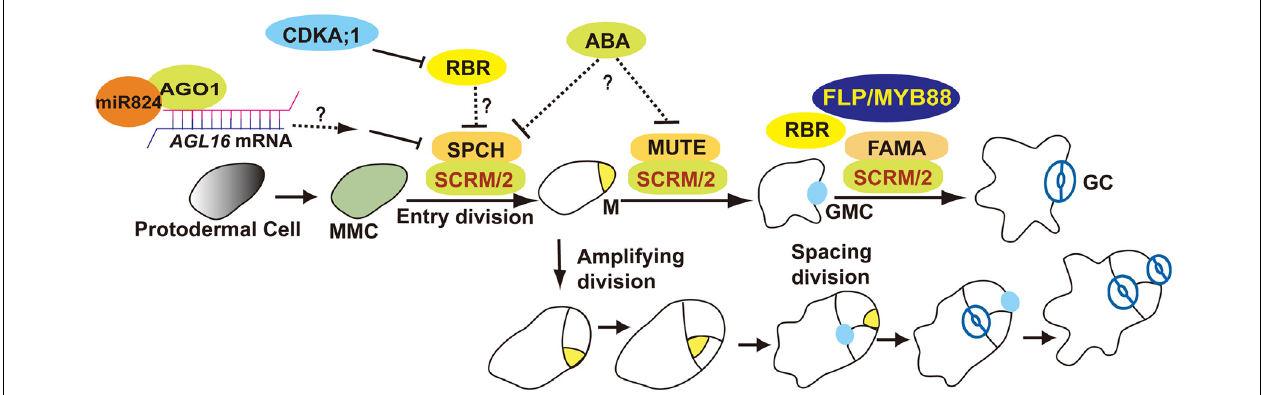
GMC. SPCH, MUTE, FAMA, and FLP/MYB88 are transcription factors that regulate key fate transitions during stomatal development. SCRM and SCRM2 heterodimerize with SPCH, MUTE, and FAMA to promote stomatal–lineage transitions. AGO1 is involved in an AGL16-mediated microRNA post-transcriptional regulatory pathway that blocks asymmetric spacing divisions in SLGCs. ABA might be involved in stomatal initiation and differentiation by repressing SPCH and MUTE. RBR activity is predominantly regulated by CDKA;1. RBR participates in the regulation of asymmetric as well as symmetric